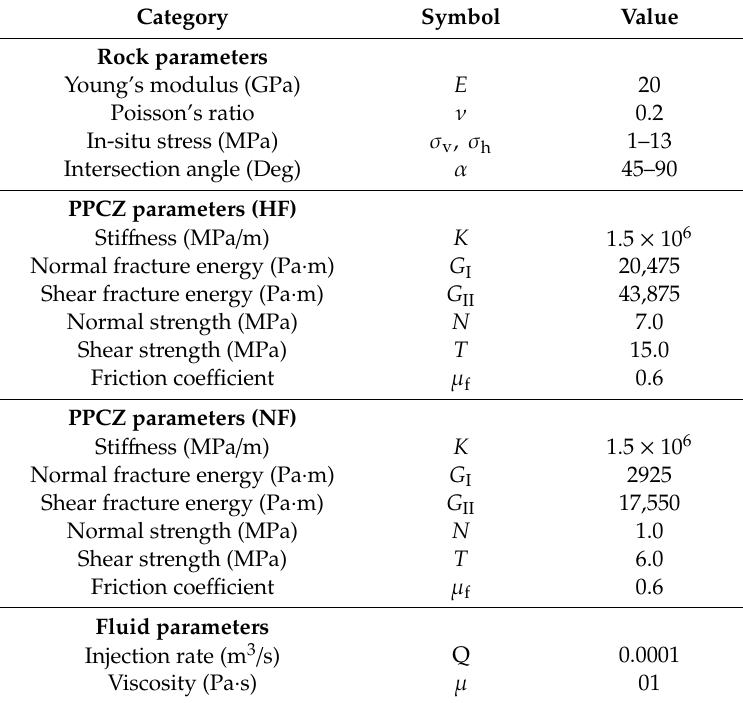
Table 2. Parameters of the fracture crossing